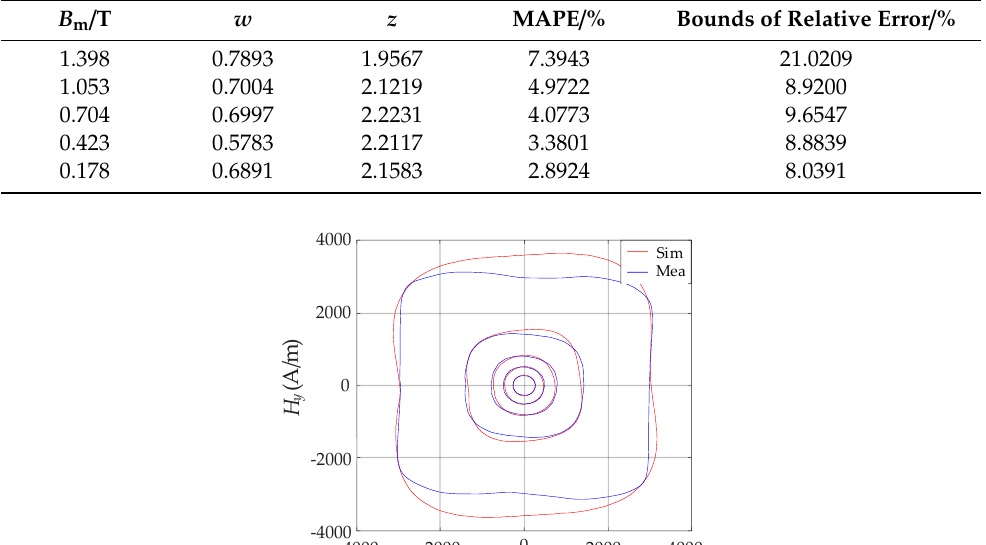
Table 1. Values of parameters and corresponding error extracted by the PSO algorithm.